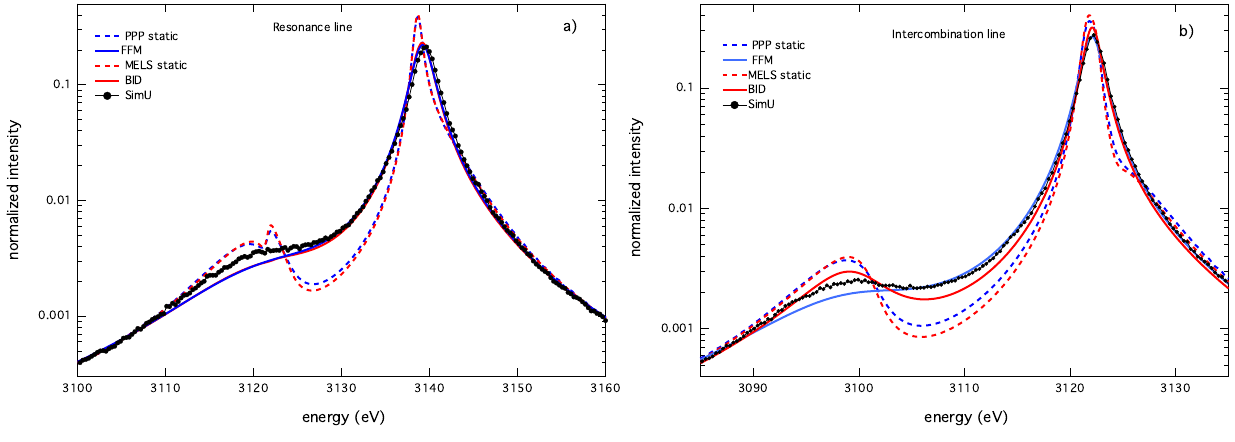
= 2 (cid:2) 10 24 cm (cid:0) 3 : ( a ) resonance line and ( b ) Figure 9. The He- (cid:11) line for T = 1 keV and n e intercombination line. Static ions MELS (red dash) and PPP (blue dash); ion dynamics BID (solid red); FFM (solid blue); and SimU (black